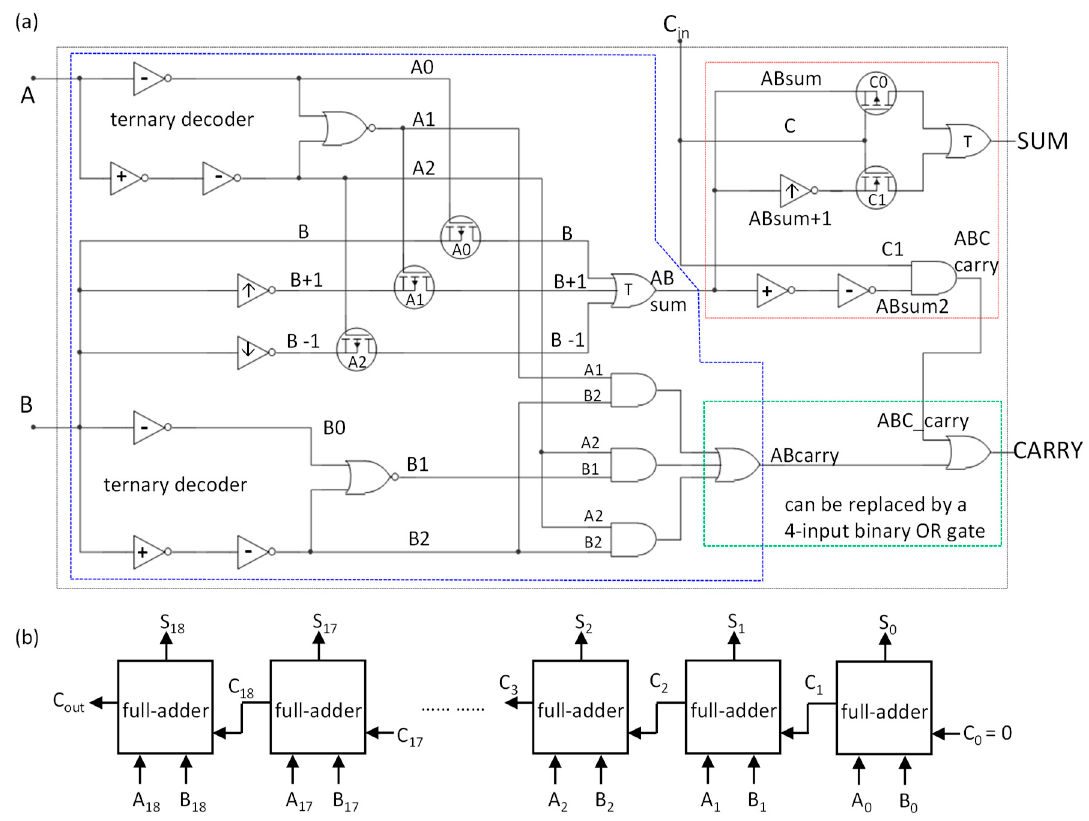
Figure 7. ( a ) Design of 1-trit full-adder. ( b ) Schematic diagram of the 19-trit ternary adder. A18A17 ... A1A0 and B18B17 ... B1B0 is ternary number of A and B, respectively. S18S17 ... S1S0 is the